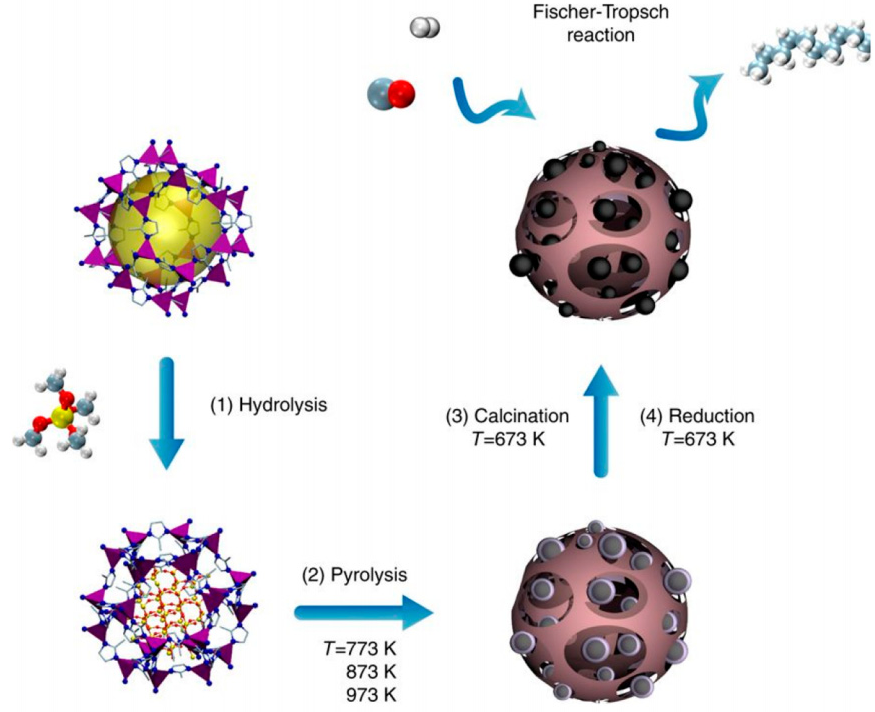
Figure 5. Schematic illustration of catalyst development from MOF precursor via pyrolysis [28].